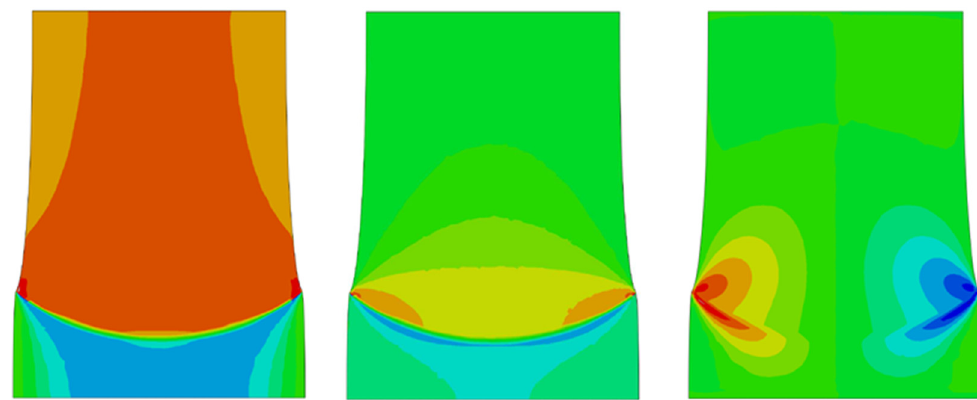
Figure 7. Magnitude distribution of the stress components in the aluminum layer; from the left: stress parallel and orthogonal to the loading direction and in-plane